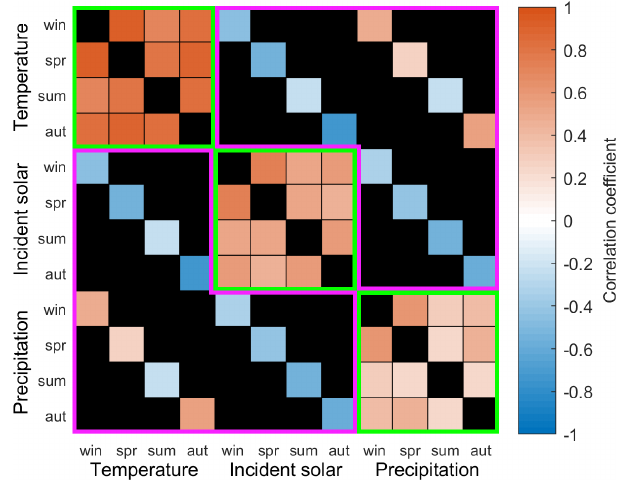
Figure 6. Correlation matrix between seasonal average climate vari- ables calculated for the late 21st century (2076–2100) using the 280 downscaled future climate time series. Within-variable, between- season correlation scores are contained within the green borders and within-season, between-variable correlation scores are contained within the purple borders. Those regions of the correlation matrix that do not cover these two groups are shaded in black.